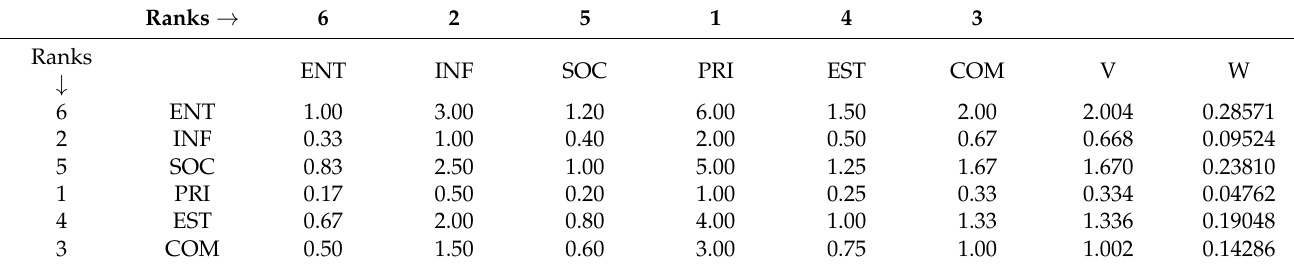
Table 4. Pairwise comparison